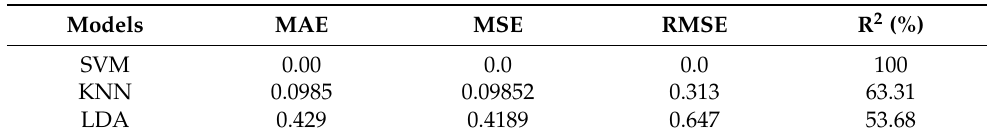
Table 10. Statistical analysis of the machine learning algorithms’ results using the CICAndMal2017 dataset.